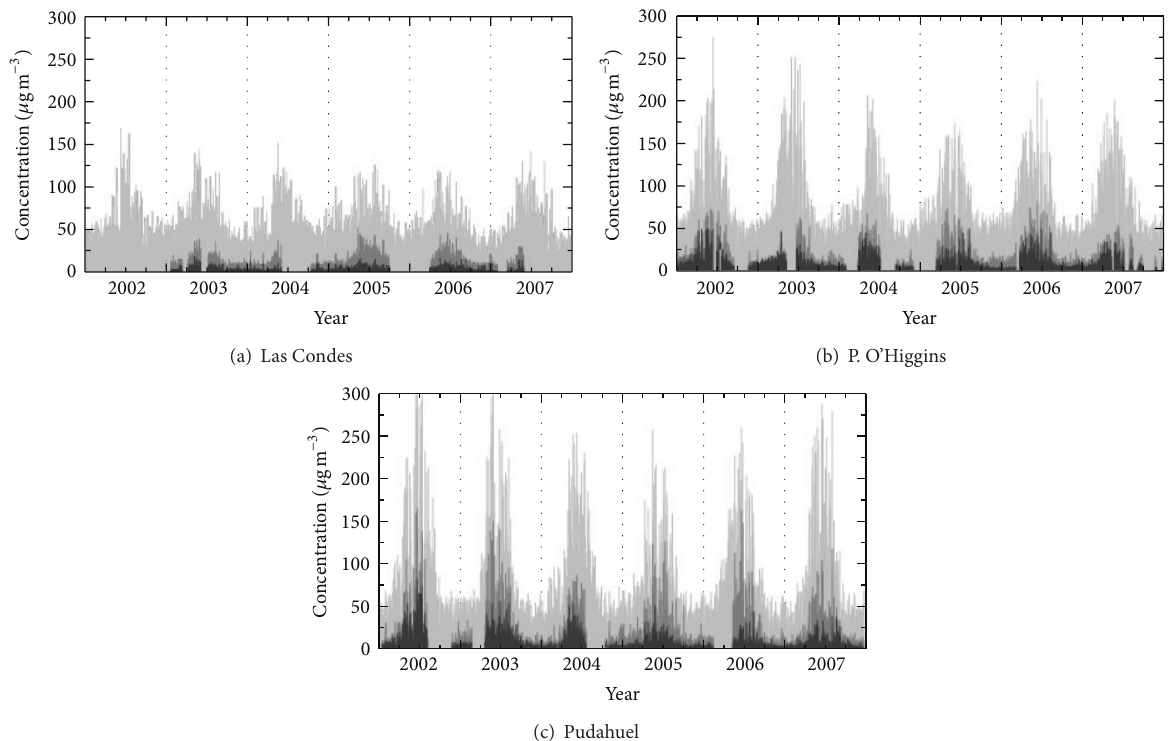
Figure 2: Hourly mass concentration (in 𝜇 g/m 3 ) time series of PM 2.5 (light gray), organic carbon (OC, gray), and elemental carbon (EC, dark gray) in PM 2.5 at the (a) Las Condes (labeled C), (b) Parque O’Higgins (labeled O), and (c) Pudahuel (labeled P) stations. The station labels are the same as in Figure 1. Data source: National Information System of Air Quality, Chilean Ministry of the Environment, Chile.